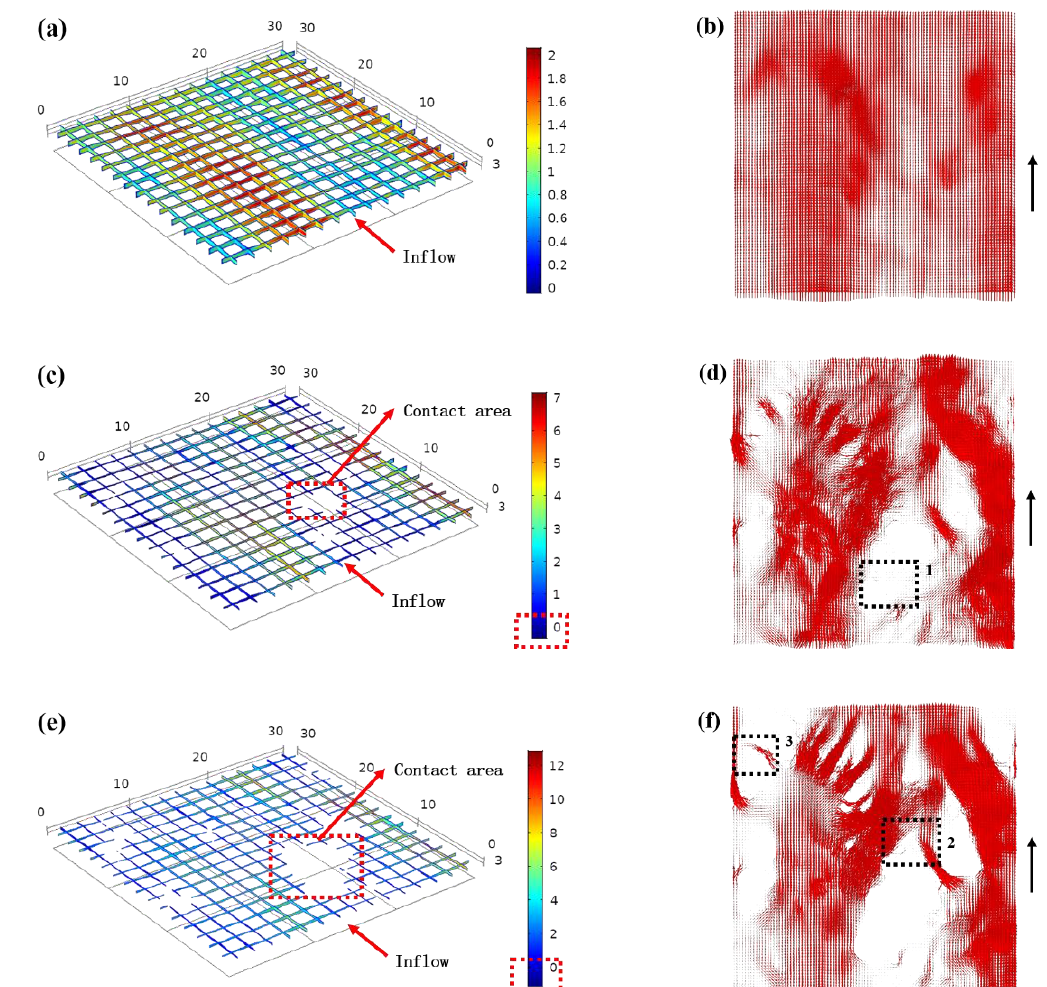
Figure 3. Velocity in the y direction of the three-dimensional fracture model when the inlet flow rate was 1.443 × 10 − 5 m 3 /s, ( a ) σ n 0 = 0.4 MPa; ( c ) σ n 0 = 0.8 MPa; ( e ) σ n 0 = 1.6 MPa; ( b , d , f ) are the arrow diagrams of flow rate corresponding to ( a , c , e ) respectively.